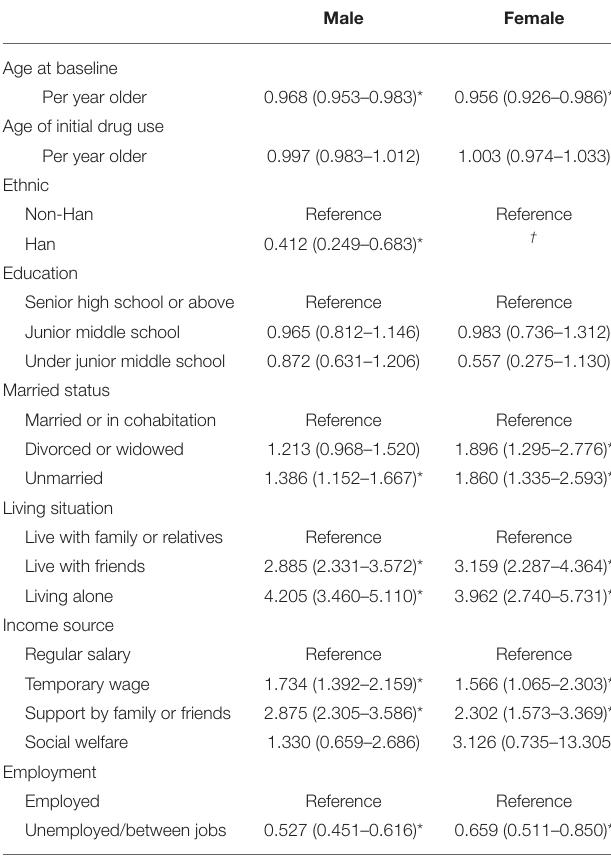
TABLE 4 | Univariable GEE analyses of factors associated with multiple sex partners in the last 3 months among PWUD on MMT in Wuhan, China, 2006–2015.